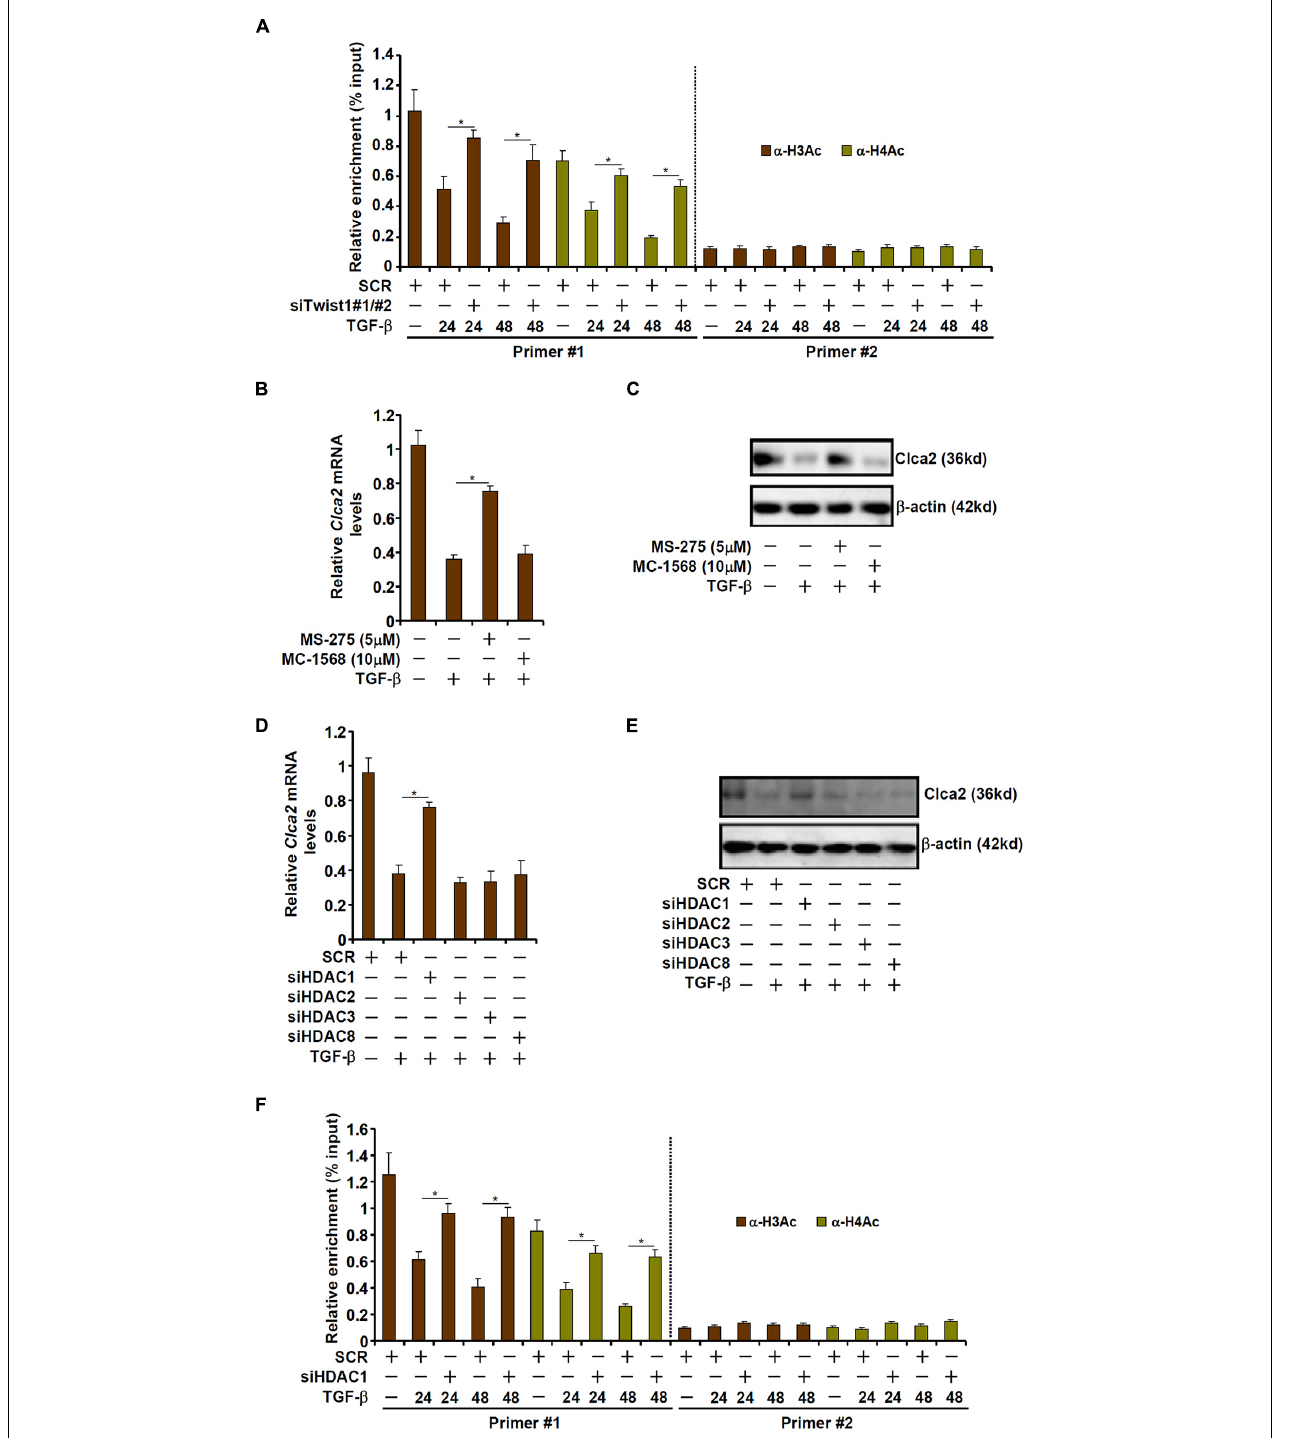
FIGURE 3 | TWIST1 represses Clca2 transcription by promoting histone deacetylation. (A) Primary murine cardiac fibroblasts were transfected with indicated siRNAs by treatment with TGF- β (2 ng/ml). ChIP assays were performed with indicated antibodies. (B,C) Primary murine cardiac fibroblasts were treated with TGF- β (2 ng/ml) in the presence or absence of different HDAC inhibitors. Clca2 expression was examined by qPCR and Western. (D,E) Primary murine cardiac fibroblasts were transfected with indicated siRNAs by treatment with TGF- β (2 ng/ml). Clca2 expression was examined by qPCR and Western. (F) Primary cardiac murine fibroblasts were transfected with indicated siRNAs by treatment with TGF- β (2 ng/ml). ChIP assays were performed with indicated antibodies. Error bars represent SD (* p < 0.05, two-way Student’s t -test). All experiments were repeated three times and one representative experiment is shown.